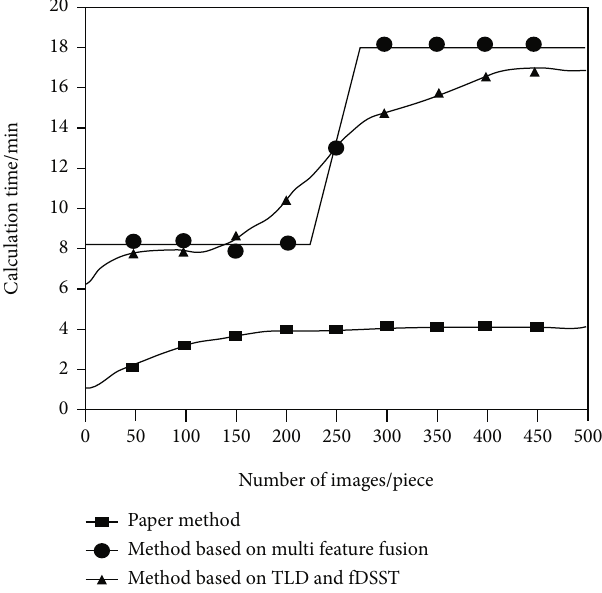
Figure 8: Comparison results of tracking